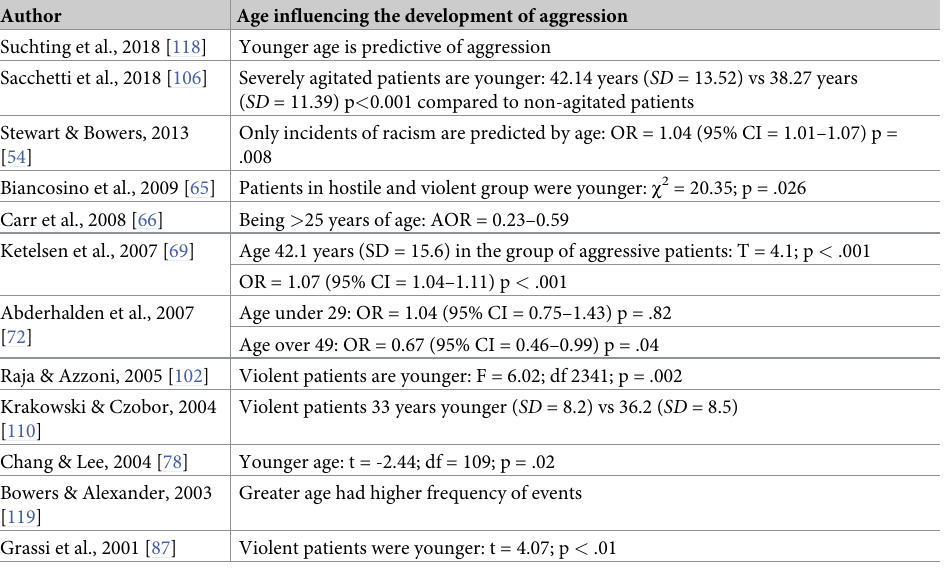
Table 4. Included studies on a possible association between age and aggression development in